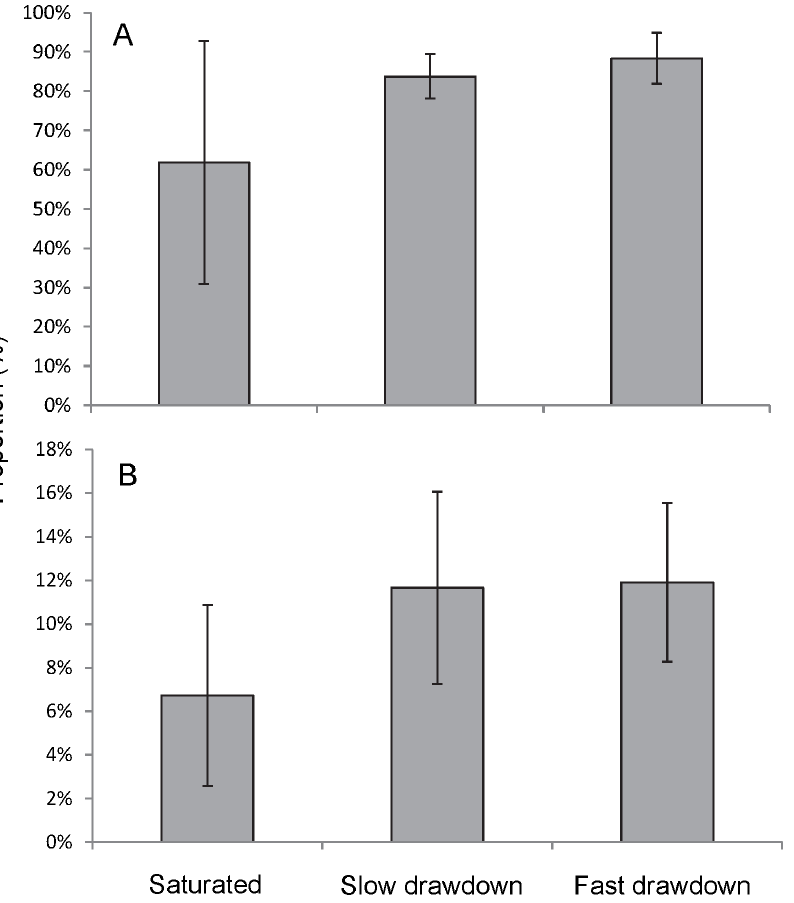
Figure 4. Mean ( ± 95% CI) proportion of copepods in the top four centimetres of the sediment. Comparison of results on mean proportion of copepods from A - the Wellington alluvium and B - the Budderoo swamp occurring in the saturated and drawdown columns; in the latter the top four centimetres represents the unsaturated zone in the fast and slow drawdown columns and shows the proportion of animals stranded above the water table as the water level is lowered.